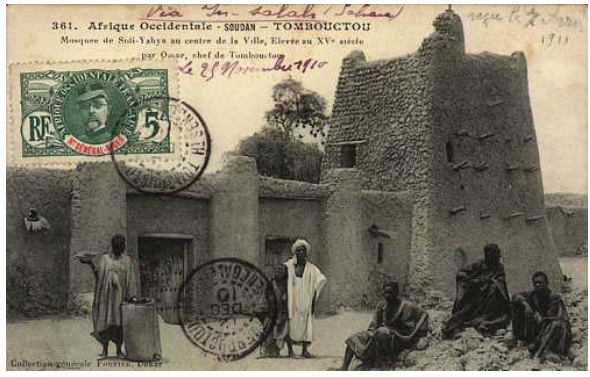
Figure 11. Postcard sent on 25 November 1910 showing Sidi Yahia Mosque with serious erosion of the eastern elevation of its minaret. (Collection Fortier – archives